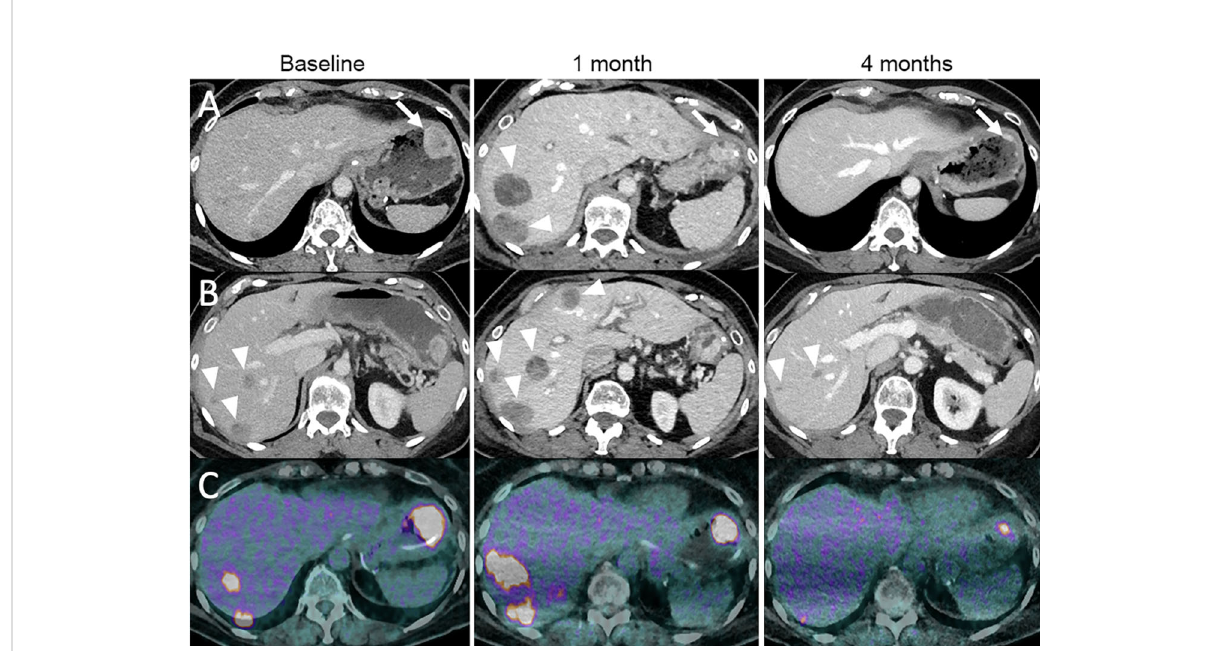
FIGURE 6 Dissociated response in a 68-year-old female with cutaneous melanoma of the back who progressed following ipilimumab (anti-CTLA-4) and nivolumab (anti-PD-1). The patient was given tumor-in fi ltrating lymphocyte-adoptive cell therapy (TIL-ACT). Baseline contrast-enhanced CT at the portal venous phase (A, B) and 18 F-FDG-PET/CT (C) show a gastric wall metastasis (arrow) and liver metastases (arrowheads). 1-month follow-up imaging after TIL-ACT demonstrates a decrease in the gastric wall metastasis (arrow). However, liver metastases increased in size (arrowheads). 4-month follow-up imaging shows a marked decrease in the gastric wall metastasis (arrow) and liver metastases (arrowheads).